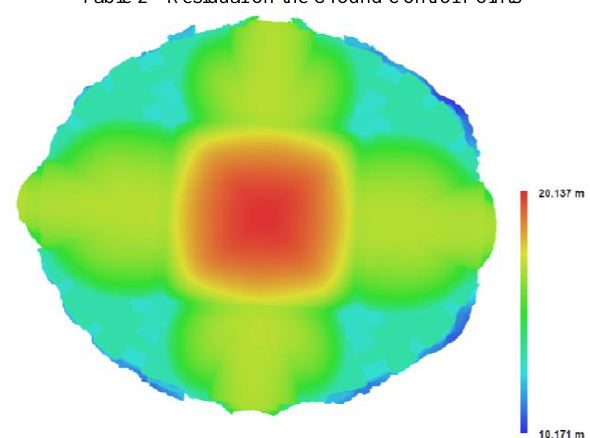
Figure 6 The digital surface model of the